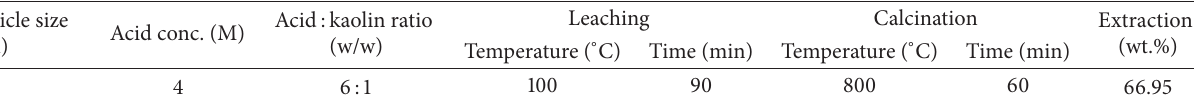
Table 2: Optimised sulphuric acid extraction conditions for alum from kaolin clay.